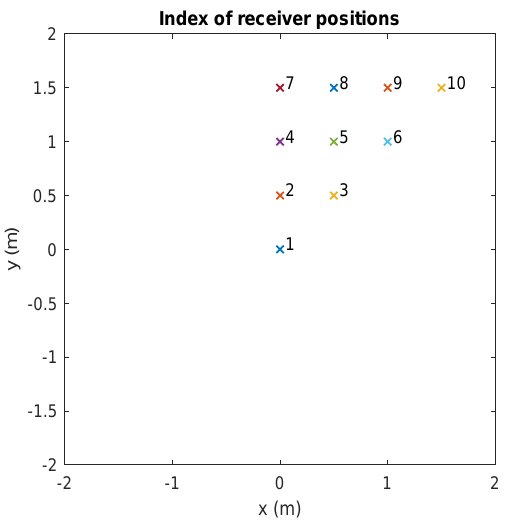
Figure 12. Indexes of the different receiver